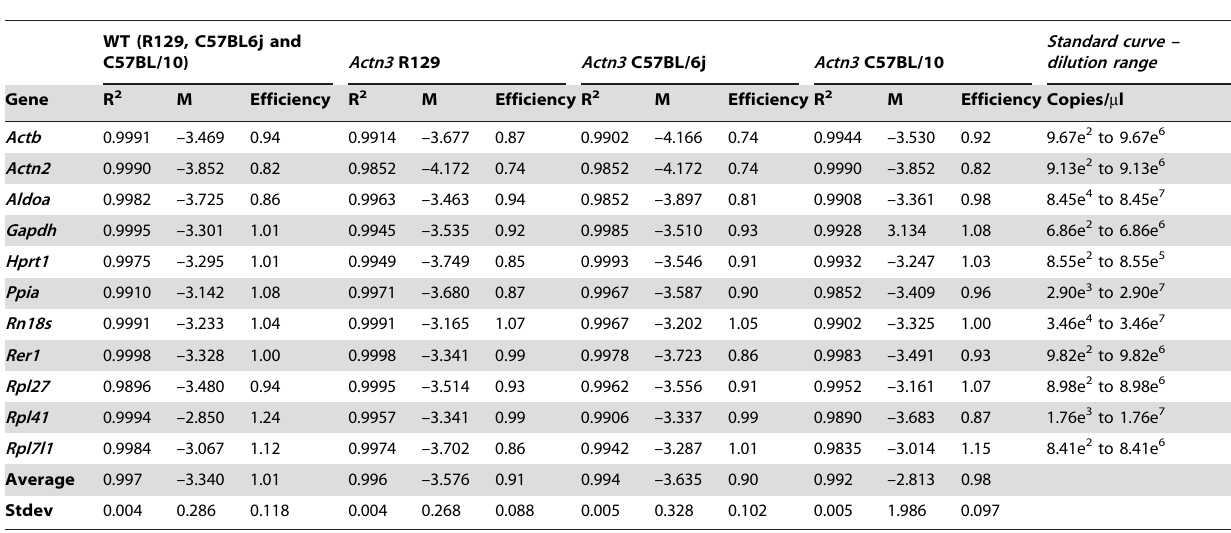
Table 3. RT-qPCR quality control (R 2 , M and Efficiency) for each